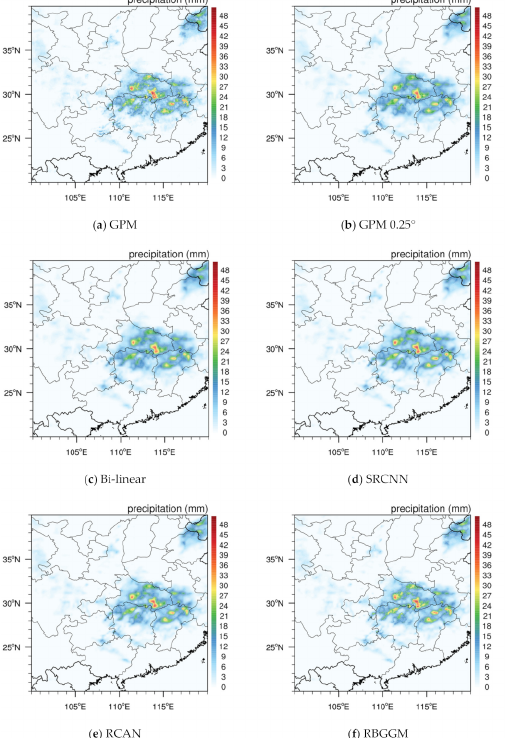
Figure 9. Distribution of GPM precipitation: ( a ) original GPM precipitation; and ( b ) GPM 0.25 ◦ ; as well as precipitation downscaling results: ( c ) bi-linear; ( d ) SRCNN; ( e ) RCAN; and ( f ) RBGGM.